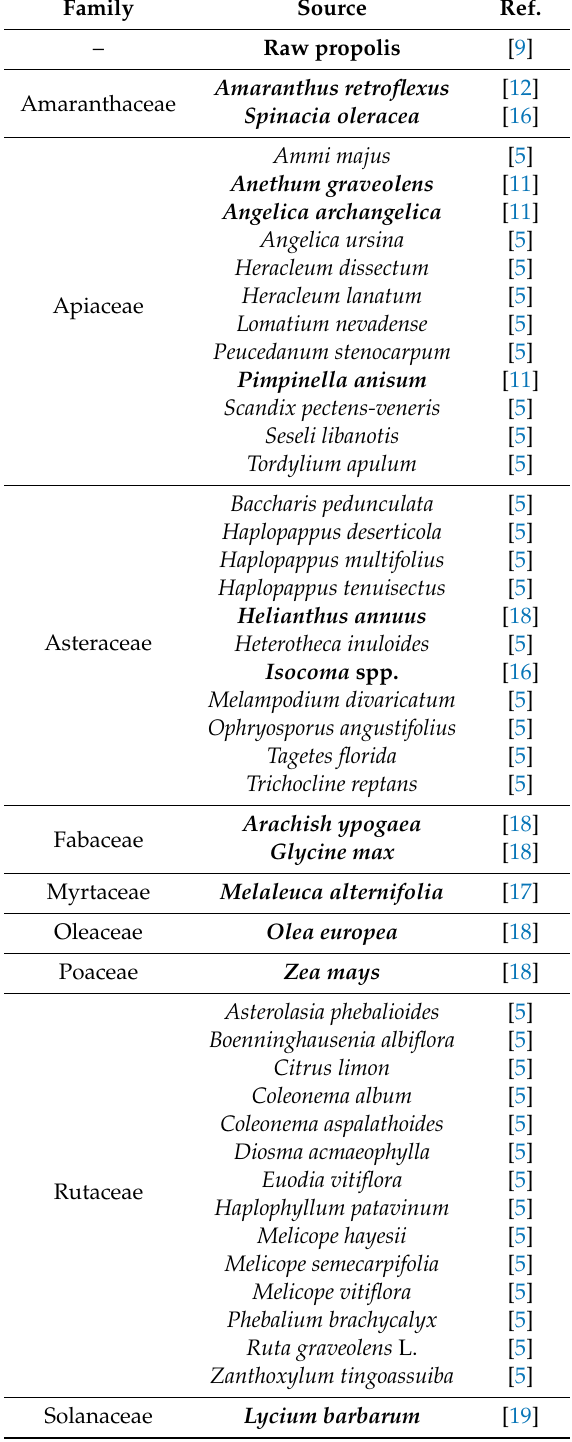
Table 1. Natural sources of 7-isopentenyloxycoumarin (sources characterized during the last decade in